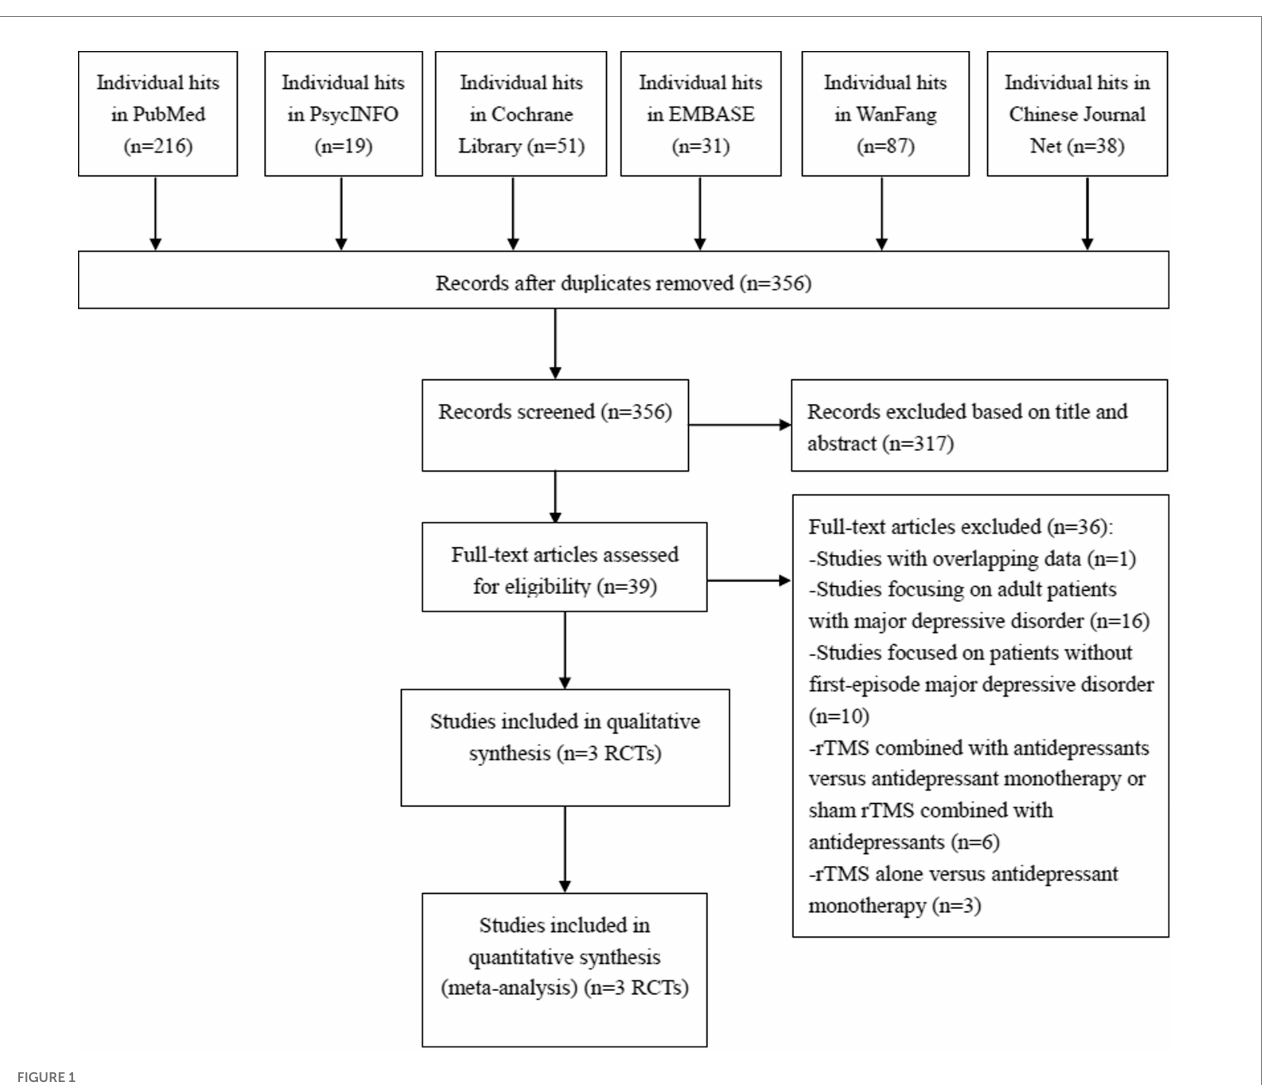
FIGURE 1 PRISMA flow